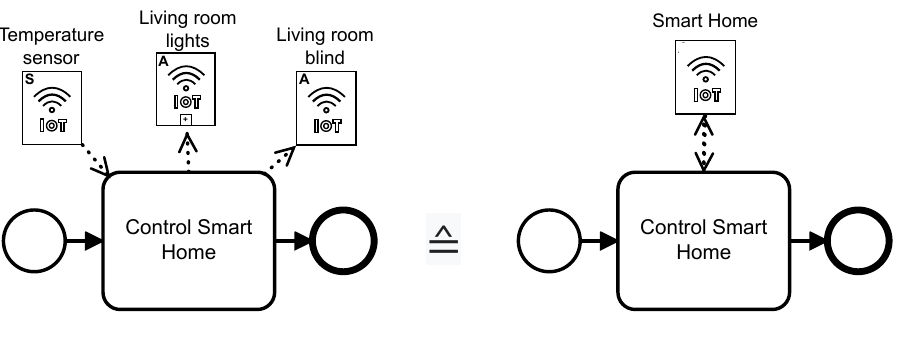
Figure 9. Usage of Object